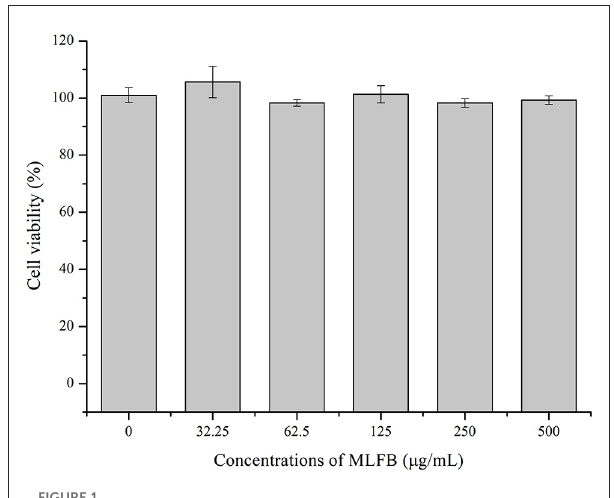
FIGURE1 Effects of MLFB on the viability of RAW 264.7 cells.